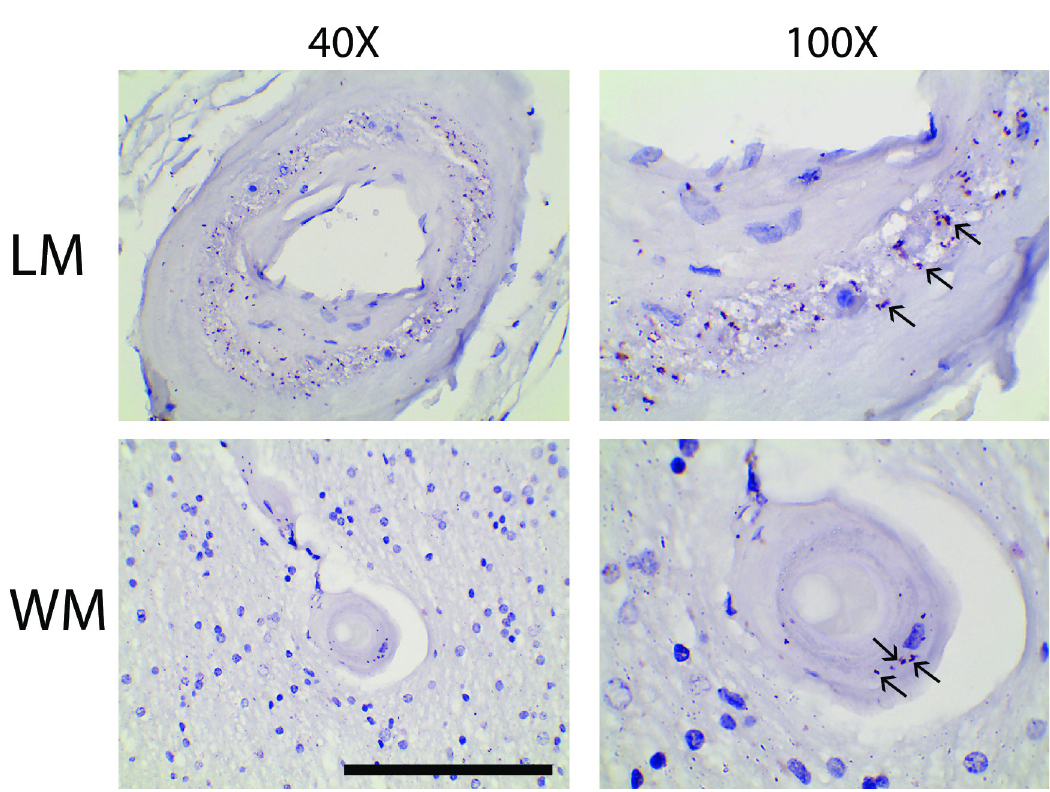
Fig 10. Proximity of CD63 and NOTCH3 fragmentation products in CADASIL. Experiments were performed to assess whether NOTCH3 fragmentation product NTF (recognized by UMI-F antibody) is in close association with CD63 (recognized by H5C6) in tissue. Arrows point to the magenta signal indicating positive PLA signal in the media, in the vicinity of vascular smooth muscle cells. Leptomeningeal (LM) and white matter (WM) arteries are shown. The left side shows 400X images; the right side shows 1000X images of a subregion of the same vessels. Scale bar shows 100 microns in the left panels.